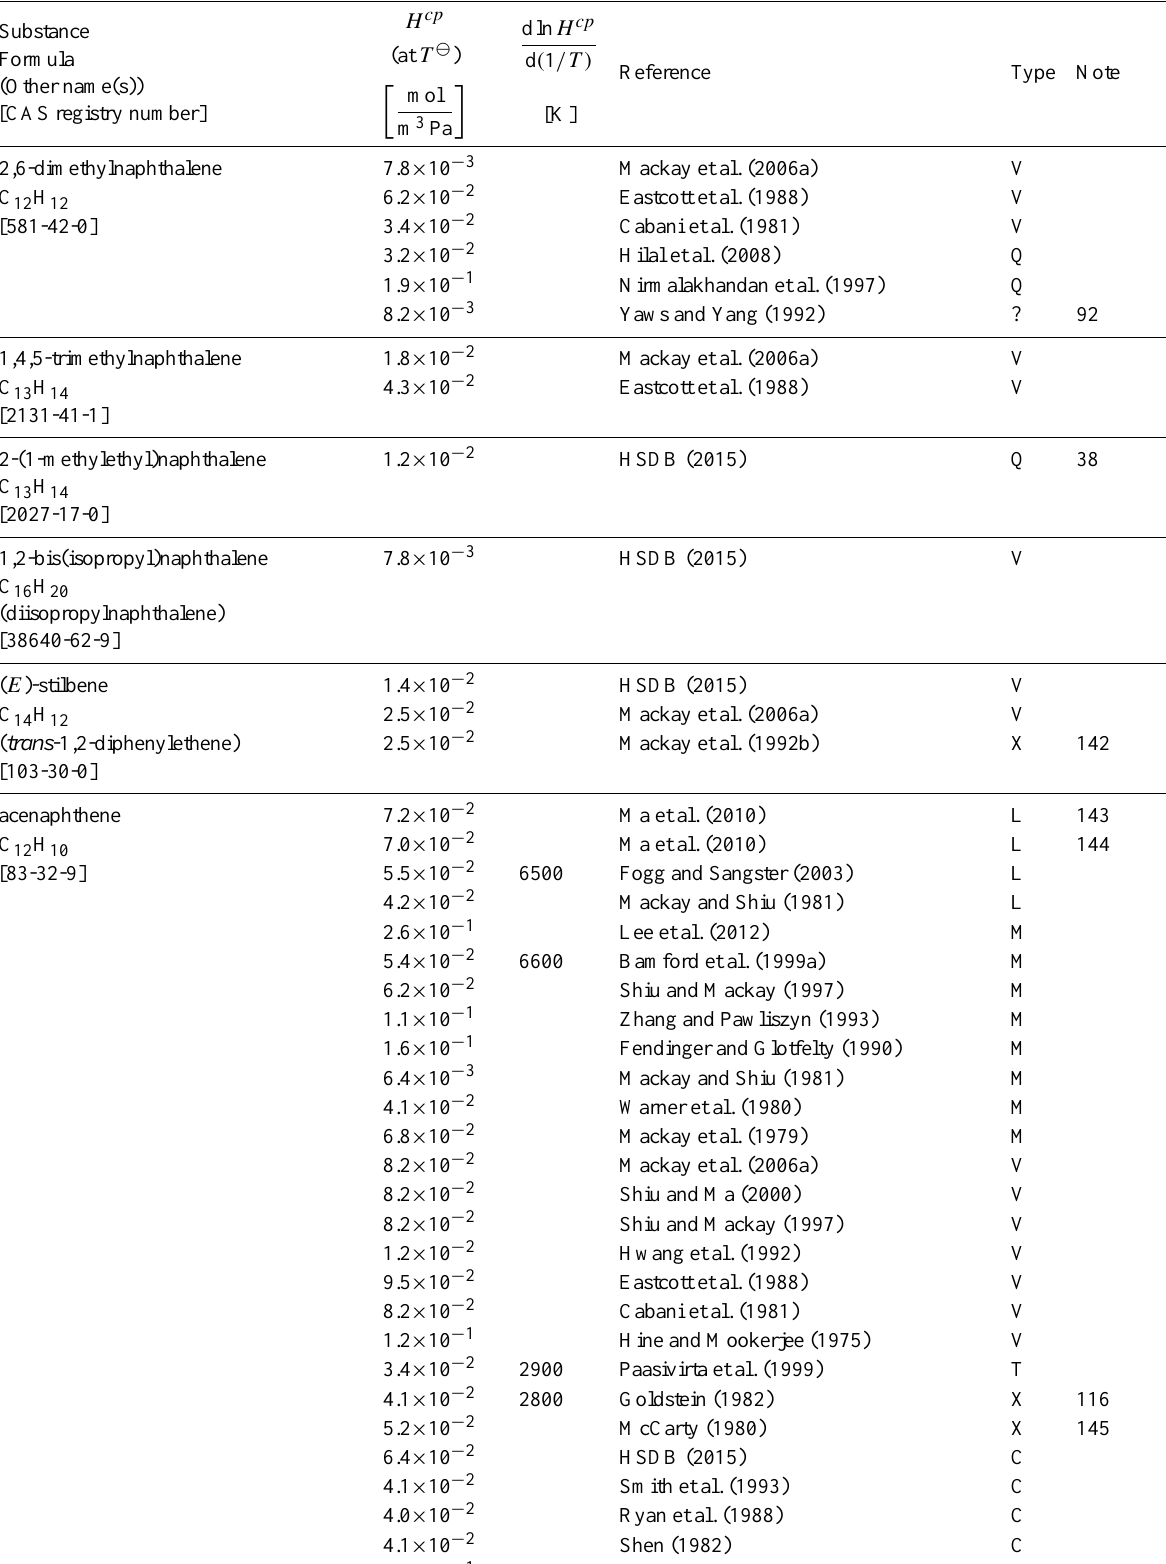
Table 6: Henry’s law constants for water as solvent